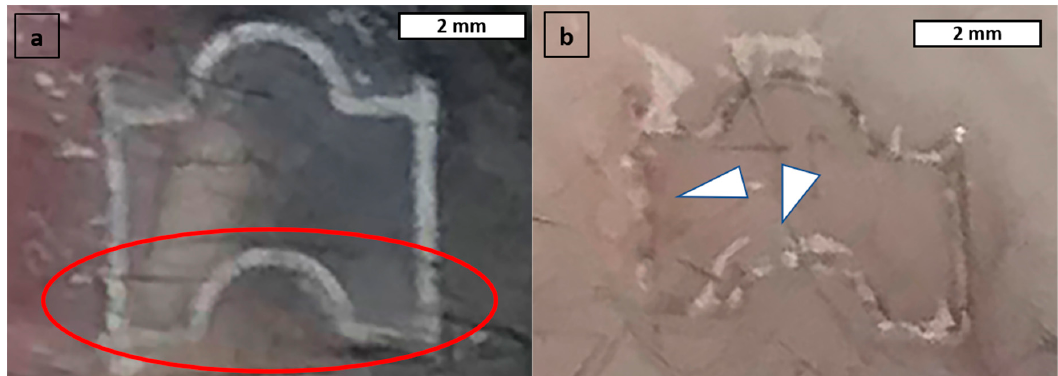
Figure 16. Optical images of ribbon segments after 15 days of subcutaneous implantation: ( a ) uncoated Zn segment. The red circle shows that the strut outlines were still similar to the original after 15 days; ( b ) AZ31 Mg alloy segments showed gaps and irregular surfaces (white arrowheads point to a few strikingly corroded areas).